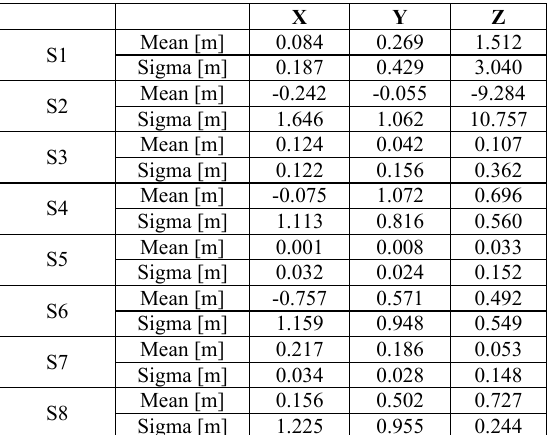
Table 3: Mean and Sigma of check point residuals separated by scenarios